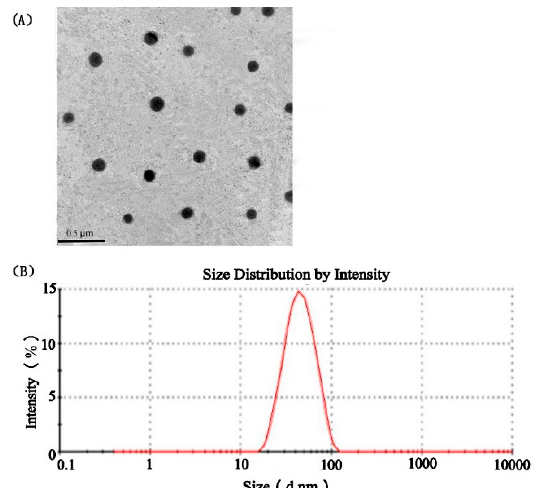
Figure 5. Characterization of the prepared PG formulations. ( A ) Transmission electron microscopy (TEM) image of the optimized phillygenin-loaded self-microemulsifying drug delivery system (PG-SMEDDS); ( B ) droplet size distribution of PG-SMEDDS.